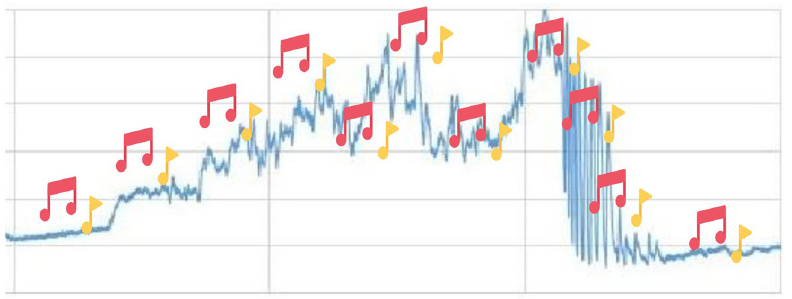
Figure 22: Mapping of pelvic muscle tension to pitch.